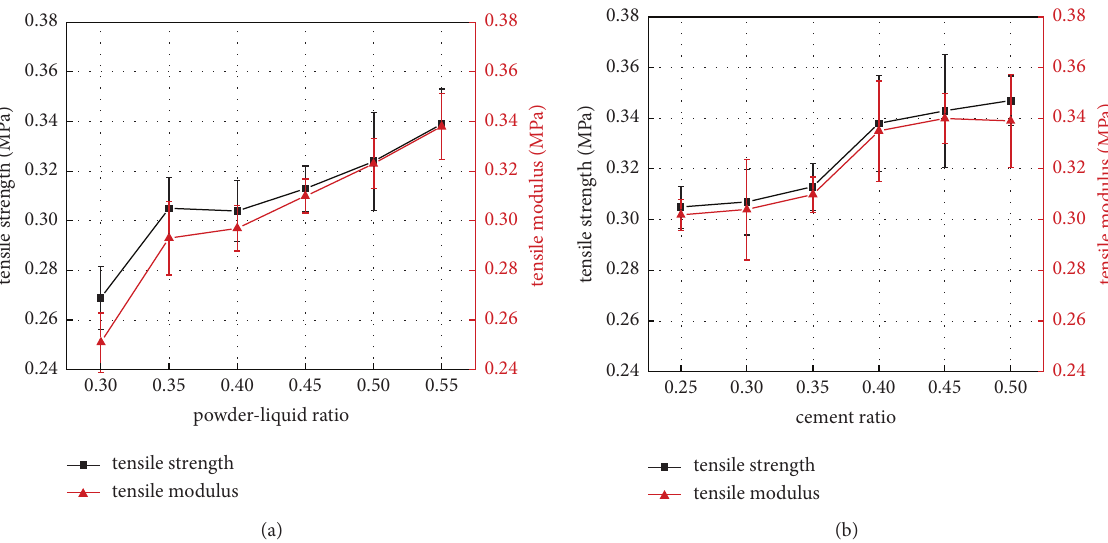
Figure 8: Changes of PCC tensile strength with powder-liquid ratio and cement ratio: (a) powder-liquid ratio; (b) cement ratio.